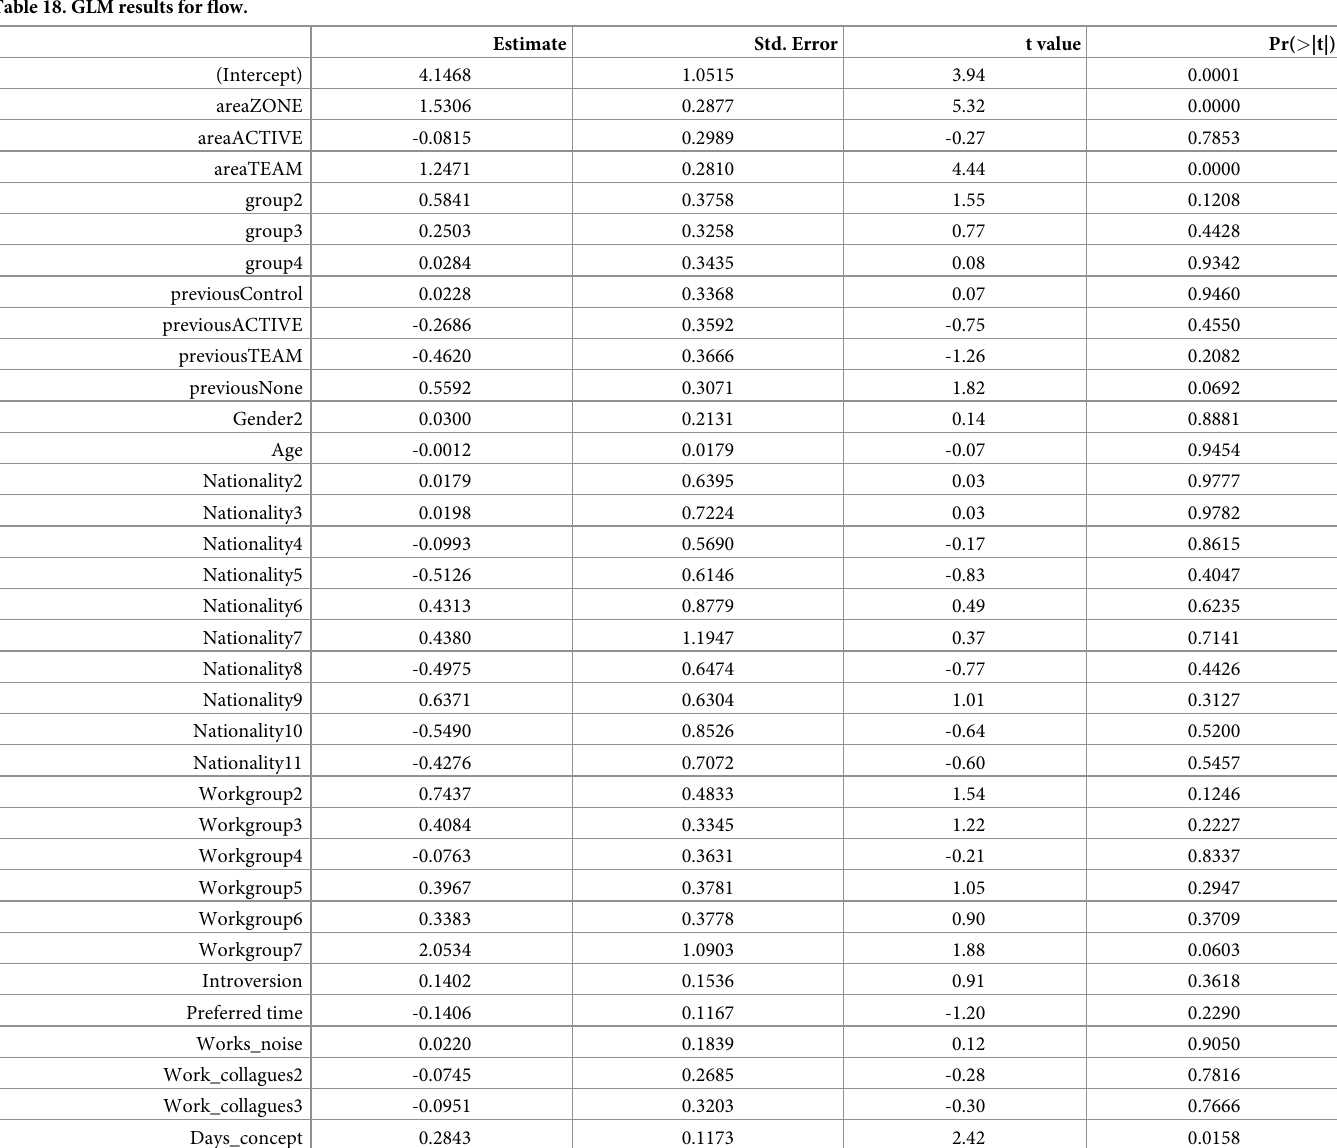
Table 18. GLM results for